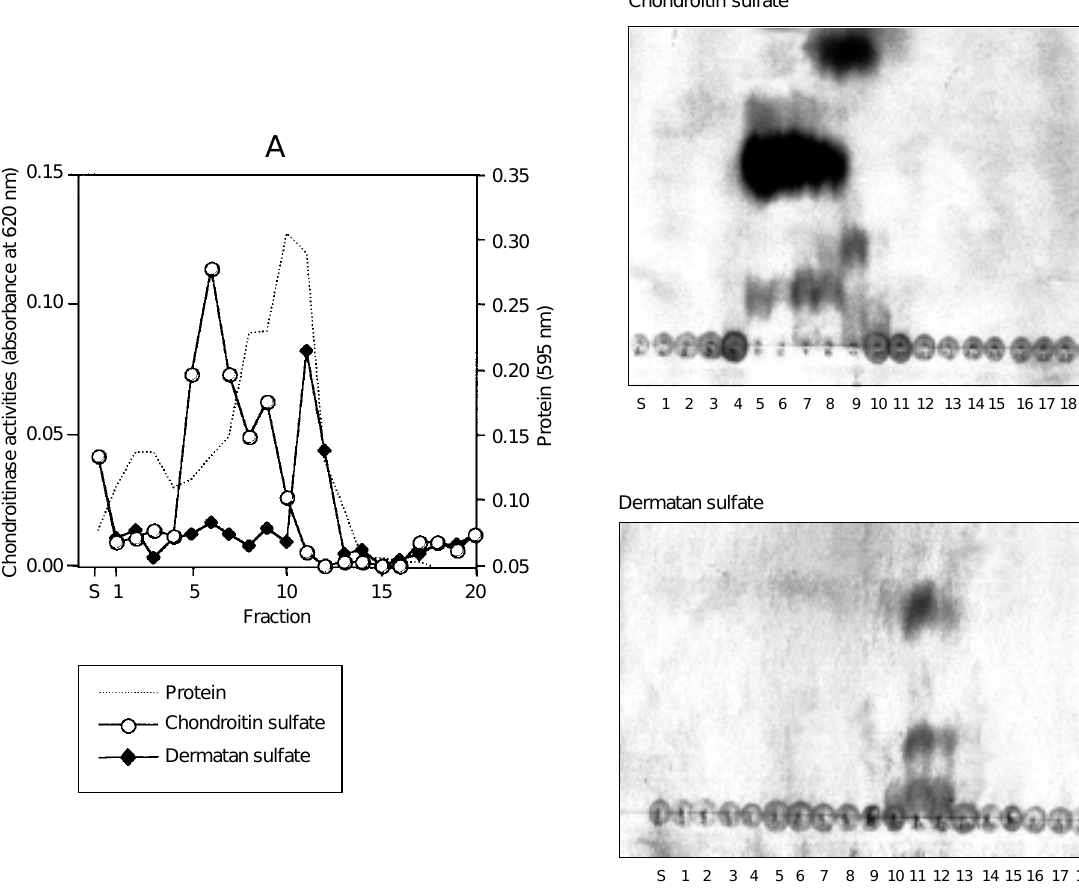
Figure 1 - Fractionation of F. heparinum chondroitinases by high performance (HP) Phenyl-Sepharose chromatography. An aliquot of F. heparinum extract containing 2 mg of protein, 1 M ammonium sulfate and 50 mM Tris-acetate buffer, pH 7.5, was applied to a 0.4 x 2-cm column of HP Phenyl- Sepharose previously equilibrated with 1 M ammonium sulfate and 50 mM Tris-acetate buffer, pH 7.5. The enzymes were eluted in a stepwise fashion with 1-ml solutions containing decreasing concentrations of (NH 4 ) 2 SO 4 in the same buffer (1.00, 1.00, 0.88, 0.75, 0.62, 0.50, 0.38, 0.25, 0.12 M), followed by 10 ml of ammonium sulfate-free buffer, at a flow rate of 0.5 ml/min. One-milliliter fractions were collected and analyzed for protein and chondroitinase activities. Total protein was estimated by the Coomassie blue method (15) and the chondroitinase activities were measured by two methods. A , Dimethylmethylene blue color shift: 10 µl of each fraction was incubated with 3 µg of chondroitin sulfate or dermatan sulfate in 96-well plates. After 4-h incubation at room temperature, 100 µl of dimethylmethylene blue reagent (16) was added and the absorbance was measured at